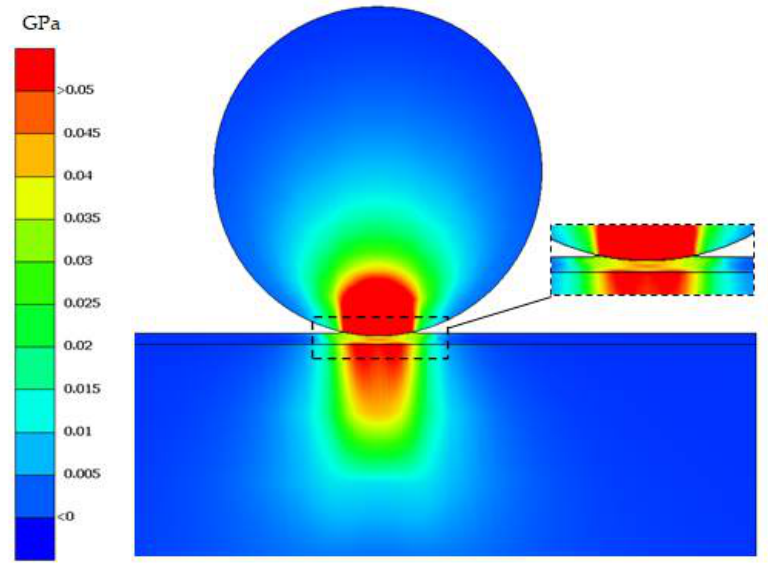
Figure 14. Equivalent stress distribution in the contact region.